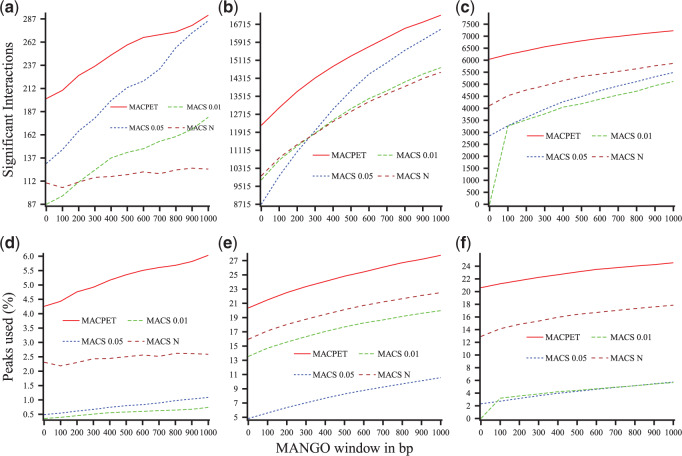
Comparison for MANGO interactions. Comparison of MANGO interaction results between significant PBSs from MACPET (peaks’ FDR \documentclass[12pt]{minimal}
\usepackage{amsmath}
\usepackage{wasysym}
\usepackage{amsfonts}
\usepackage{amssymb}
\usepackage{amsbsy}
\usepackage{upgreek}
\usepackage{mathrsfs}
\setlength{\oddsidemargin}{-69pt}
\begin{document}
}{}$<0.05$\end{document}) and MACS (peaks’ FDR \documentclass[12pt]{minimal}
\usepackage{amsmath}
\usepackage{wasysym}
\usepackage{amsfonts}
\usepackage{amssymb}
\usepackage{amsbsy}
\usepackage{upgreek}
\usepackage{mathrsfs}
\setlength{\oddsidemargin}{-69pt}
\begin{document}
}{}$<0.05$\end{document}, FDR \documentclass[12pt]{minimal}
\usepackage{amsmath}
\usepackage{wasysym}
\usepackage{amsfonts}
\usepackage{amssymb}
\usepackage{amsbsy}
\usepackage{upgreek}
\usepackage{mathrsfs}
\setlength{\oddsidemargin}{-69pt}
\begin{document}
}{}$<0.01$\end{document} and top \documentclass[12pt]{minimal}
\usepackage{amsmath}
\usepackage{wasysym}
\usepackage{amsfonts}
\usepackage{amssymb}
\usepackage{amsbsy}
\usepackage{upgreek}
\usepackage{mathrsfs}
\setlength{\oddsidemargin}{-69pt}
\begin{document}
}{}$N$\end{document} most significant peaks), for different PBSs extension windows. For all the plots, the x-axis is the number of bp. Each PBS interval was extended from either side before running MANGO. (a–c) Total significant interactions (y-axis) for (a) ESR1 (MCF-7), (b) CTCF (MCF-7), (c) CTCF (K562). (d–f) Proportion of significant PBSs involved in significant interactions (y-axis) for (d) ESR1 (MCF-7), (e) CTCF (MCF-7), (f) CTCF (K562).